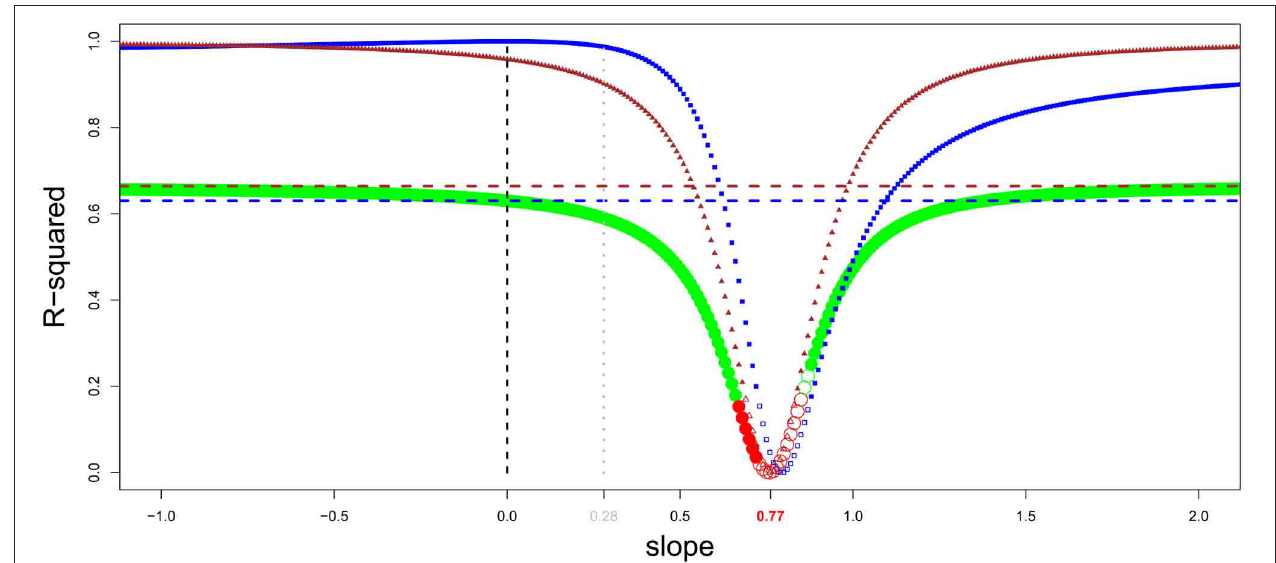
FIGURE 7 | Generalintelligencescores and encephalizationslope in primates(brainand bodydatafrom Kirk,2006,generalintelligencescores from Deaneret al.,2006). Residuals from regressionof brain onto body masseshavebeenobtainedbyvaryingtheencephalizationslopevaluefrom − 1 to 2 (step = 0.01).Foreverygiven slope,a linear regressionbetween intelligencescoresontobrain/bodyresidualshasbeencarriedout.Theresulting r -squaredis indicated bygreendotswhen the regressionis significant, and by reddotswhen it is not. In addition,the dotsare filled whenresiduals correlate